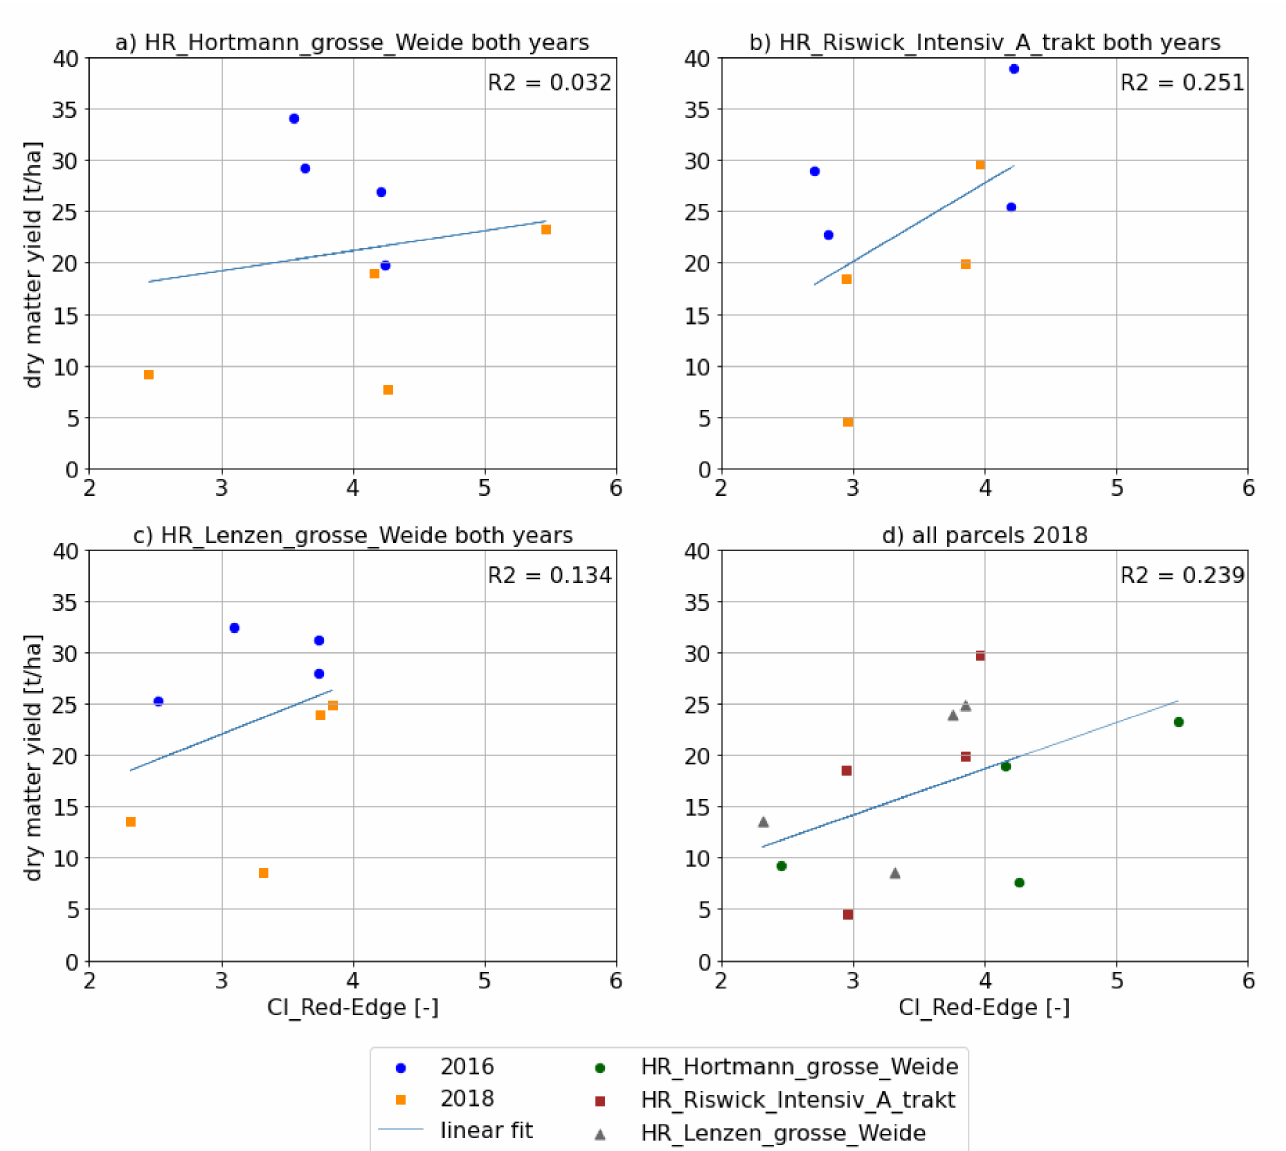
Figure 8. Scatterplots CI Red-Edge index vs dry matter yield for the parcels Hortmann grosse Weide, Intensiv A-trakt, Lenzen grosse Weide for the years 2016 and 2018 combined ( a – c ), and for all three parcels combined for the year 2018 ( d